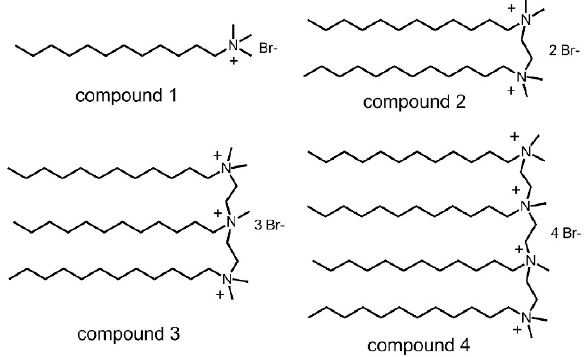
Figure 8. Chemical structures of the cationic oligomeric surfactants (compounds 2–4) and the corresponding monomeric analog (compound 1).